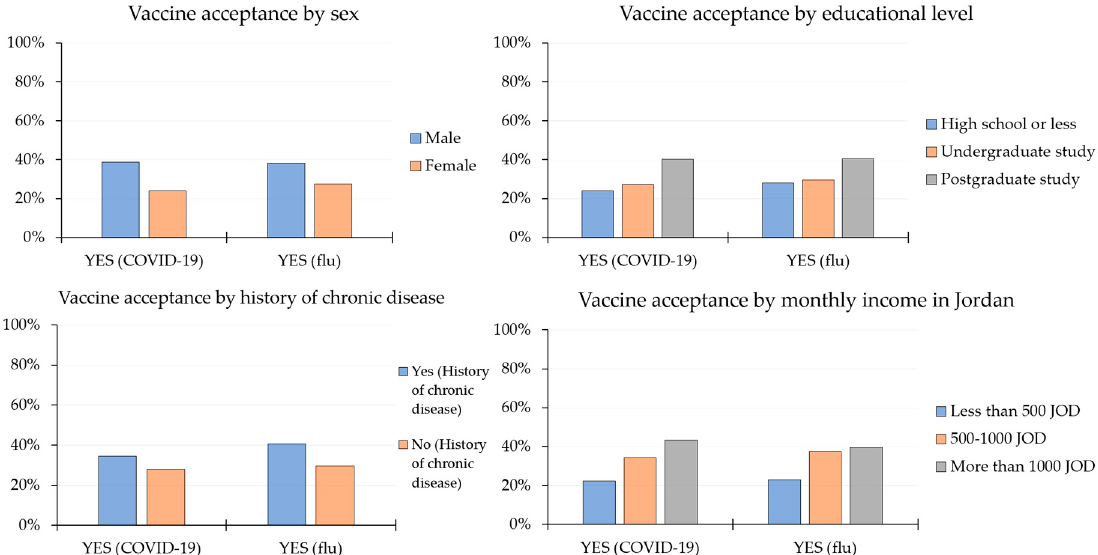
Figure 1. Vaccine acceptance rates stratified by sex, educational level, history of chronic disease and monthly income (for respondents in Jordan only). Analysis was conducted for COVID-19 prospective vaccines and influenza (flu) vaccines.